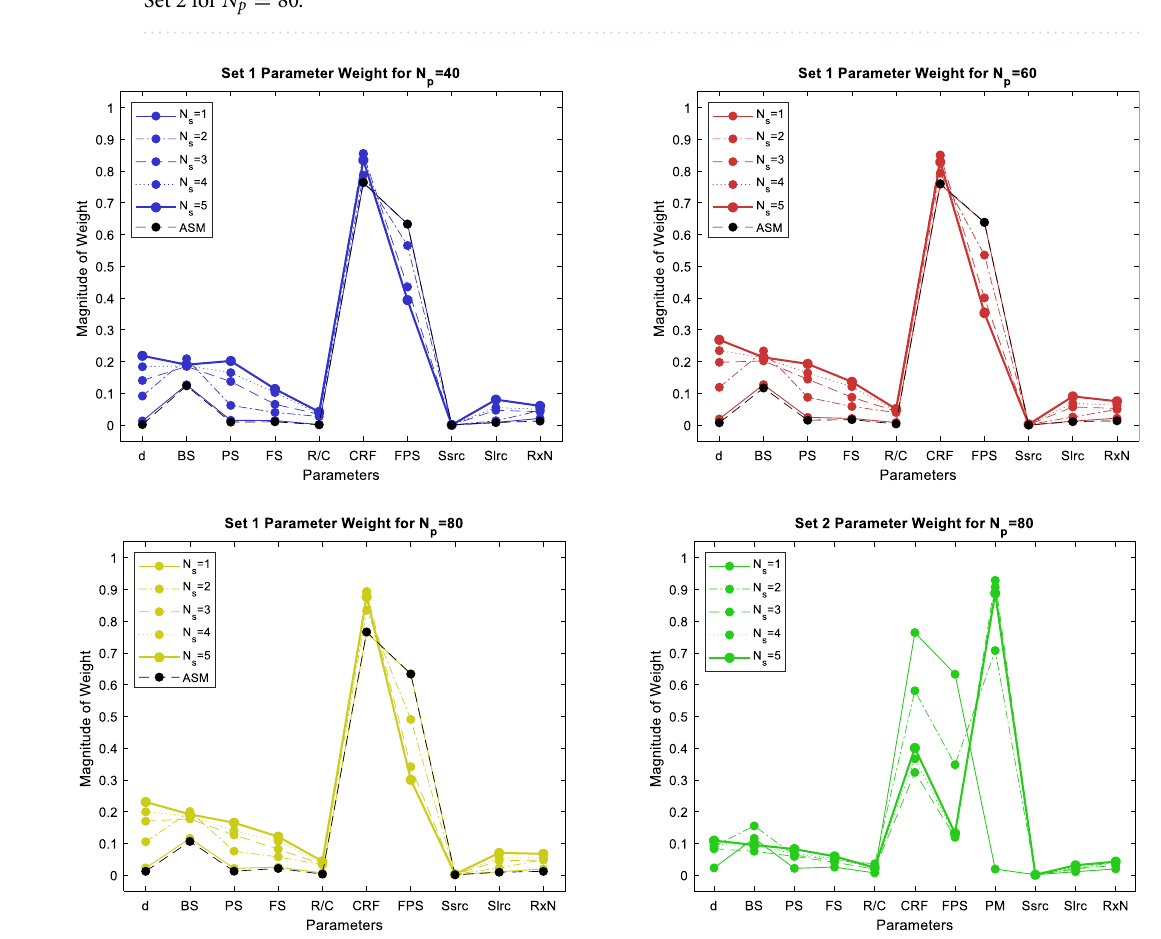
Figure 4. Magnitude of the components of approximated first eigenvector ( a ) Set 1 for N p = 40 , ( b ) Set 1 for N p = 60 , ( c ) Set 1 for N p = 80 ( d ) Set 2 for N p = 80